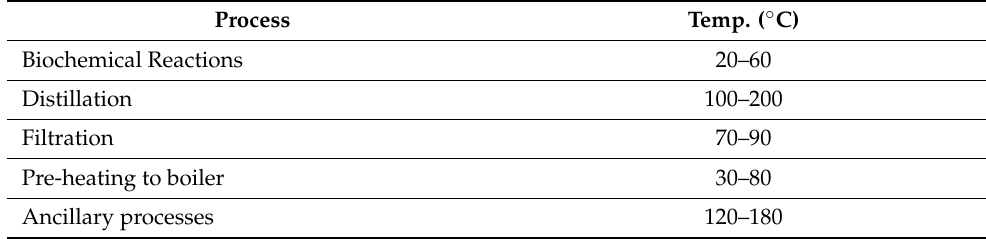
Table 7. Chemical industry process